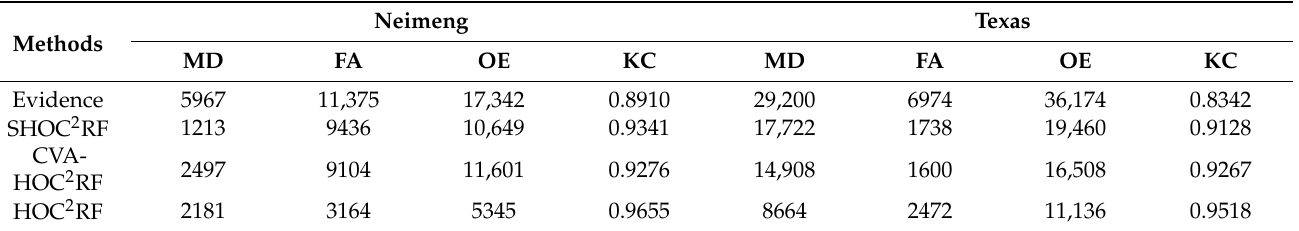
Table 6. CD results obtained by evidence theory, SHOC 2 RF, CVA-HOC 2 RF and HOC 2